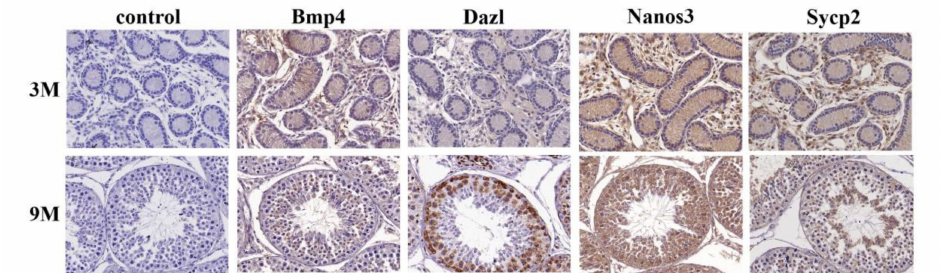
Figure 3. The expression location of Bmp4, Dazl, Nanos3 and Sycp2 in 3M and 9M sheep testis tissues. Immunohistochemistry was performed to detect the expression location of the four genes in sheep testis tissues. The staining results were observed under a microscope at a magnification of 40 × . Control presented the negative staining; Bmp4, Dazl, Nanos3 and Sycp2 presented the positive staining. Blue and brown represented nuclear and gene positive staining, respectively. The terms 3M and 9M refer to the 3-month-old and 9-month-old testis tissues of sheep,